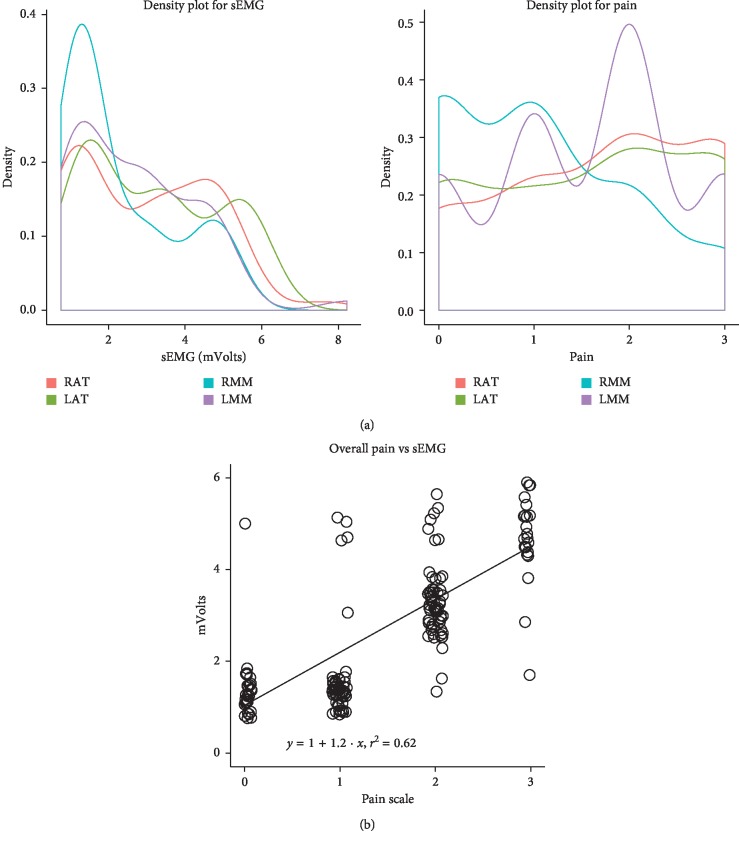
(a) Density plot for sEMG (mVolts) and pain (scale 0–3) at the level of right anterior temporalis (RAT), left anterior temporalis (LAT), right masseter muscle (RMM), and left masseter muscle (LMM). (b) Overall moderate correlation between muscle tenderness and sEMG values (y = 1 + 1.2x; r2 = 0.62; p < 0.0001). Segregation of data occurs according to tenderness and sEMG values, with lower pain scores (0-1) associated with lower sEMG values (<2 mV) and higher pain scores (2-3) associated with higher sEMG values (>2 mV).